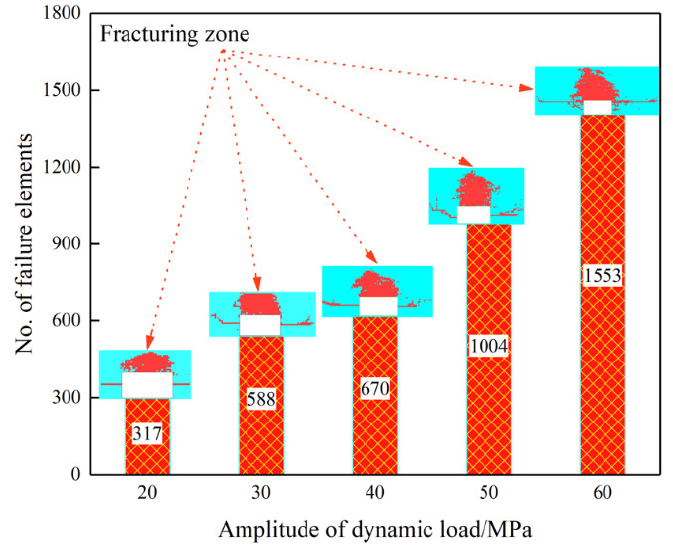
Figure 13. Failure characteristics and number of failure elements (model I).